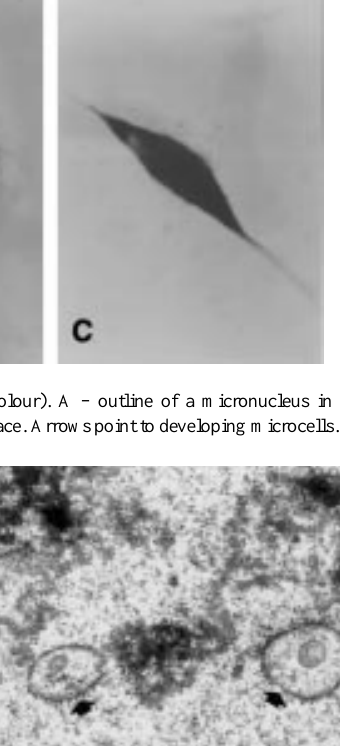
of time, the nuclear bodies increased in size and moved toward the nuclear envelope (Fig. 8). The